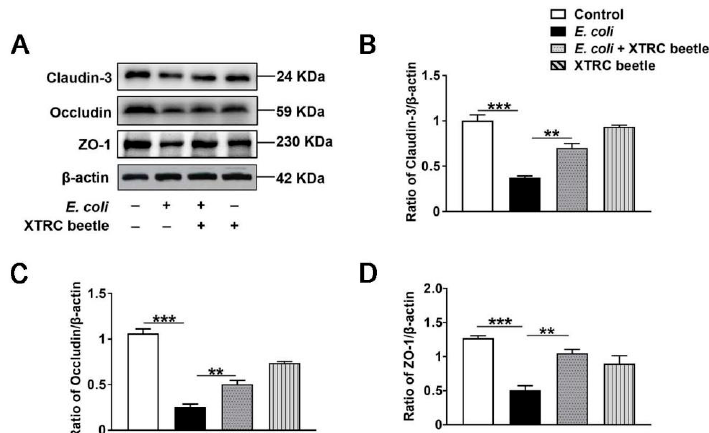
Figure 7. Effect of Z. morio hemolymph on the the protein levels of Claudin3, Occludin and ZO-1 in PMECs. ( A ) Expression of TJ proteins was determined by Western blotting. ( B – D ) Panel shows the protein quantification of TJ proteins using ImageJ software (version 1.50). XTRC beetle stands for Z. morio hemolymph-treatment. Data presented are means ± SEM ( n = 3 per group). ** p < 0.01, *** p < 0.001.